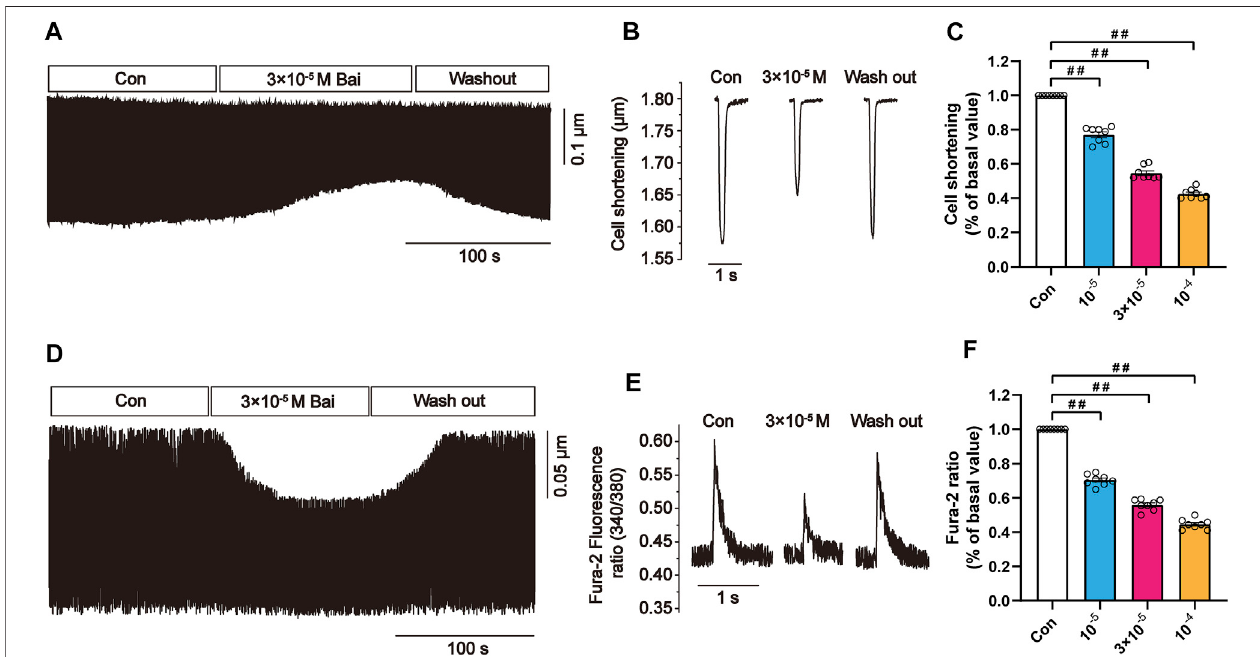
FIGURE 9| Effects of Bai on myocyte contractions and Ca 2+ transients in rat cardiomyocytes. (A,D) Time course and (B,E) typical traces recorded in Con and Bai (3×10 − 5 M). (C,F) PooleddataofmyocytecontractionsandCa 2+ transientsunderConandBai(10 − 5 ,3×10 − 5 ,and10 − 4 M).Valuesarepresentedasmeans±S.E.M. p < 0.01, p < 0.05 versus Con, n = 6-8 cells.